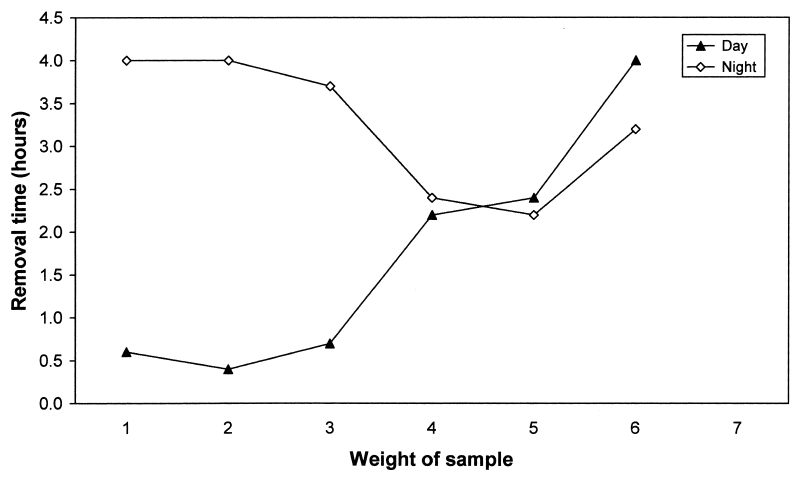
Fig. 3. Graph showing the mean time (n = 10) for bait of different weights to be re- moved from roads by day and night. (NB: x-axis: 1 = 25 g; 2 = 50 g; 3 = 100 g; 4 = 150 g; 5 = 200 g; 6 = 500 g).